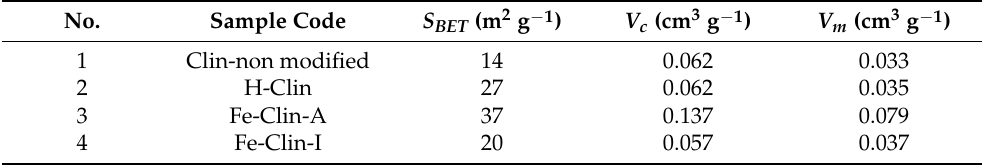
Table 1. Specific surface area ( S BET ), total pore volume ( V c ), and mesopore volume ( V m ) of the analyzed samples obtained from adsorption/desorption nitrogen measurements at − 196 ◦